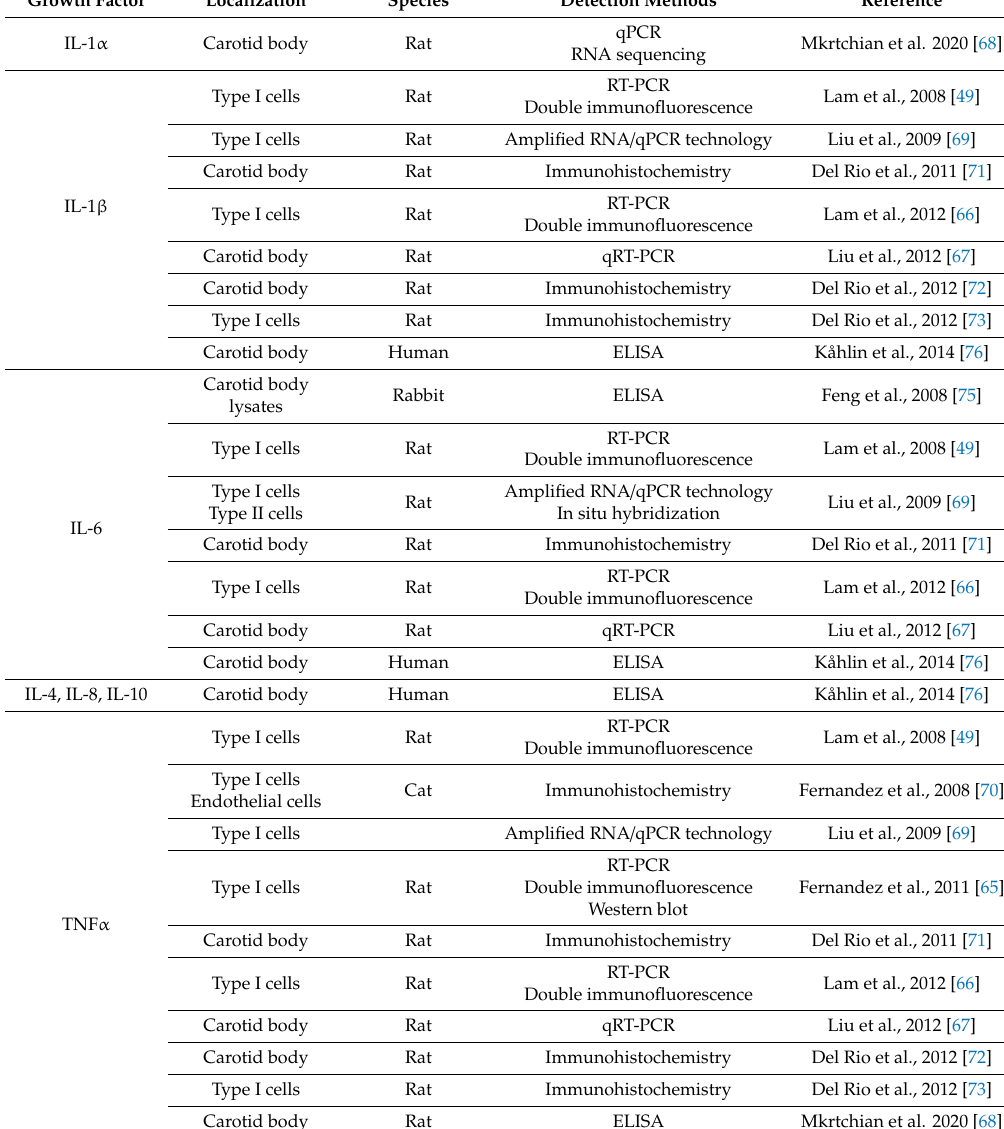
Table 8. Inflammatory cytokines. Expression of IL-1 β , IL6, IL-4, IL-8, IL-10, and TNF α in the carotid